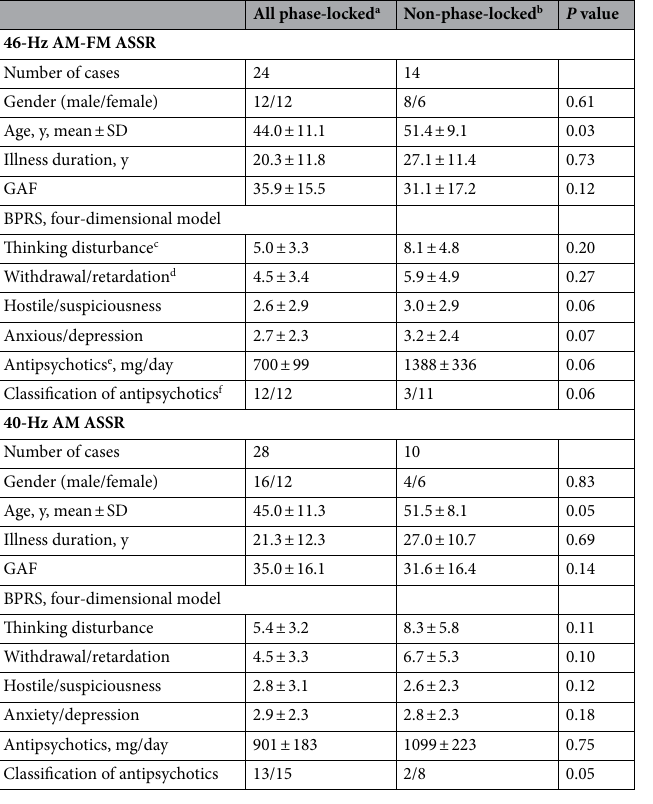
Table 2. Comparison of clinical variables between all phase-locked and non-phase-locked groups in schizophrenia. a The group of patients who had the phase-locked responses in all three measurements (patients without non-phase-locked responses). b The group of patients who had non-phase-locked responses, at least one in three measurements (patients with non-phase-locked responses). c Positive symptoms. d Negative symptoms. e Chlorpromazine equivalent dose. f New generation antipsychotics only/Conventional antipsychotics or combination (new generation and conventional